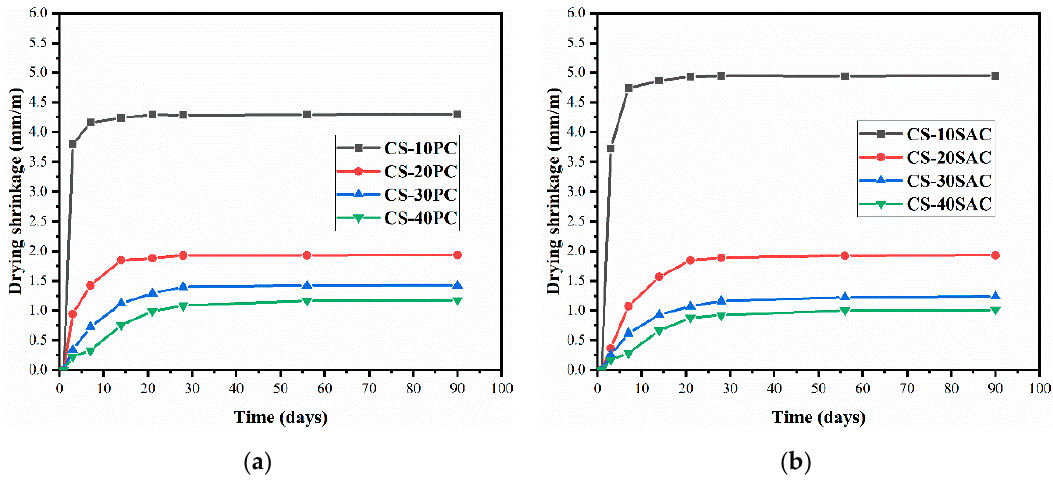
Figure 7. Drying shrinkage of blended mortars: ( a ) CS-PC blended mortars; ( b ) CS-SAC blended mortars.